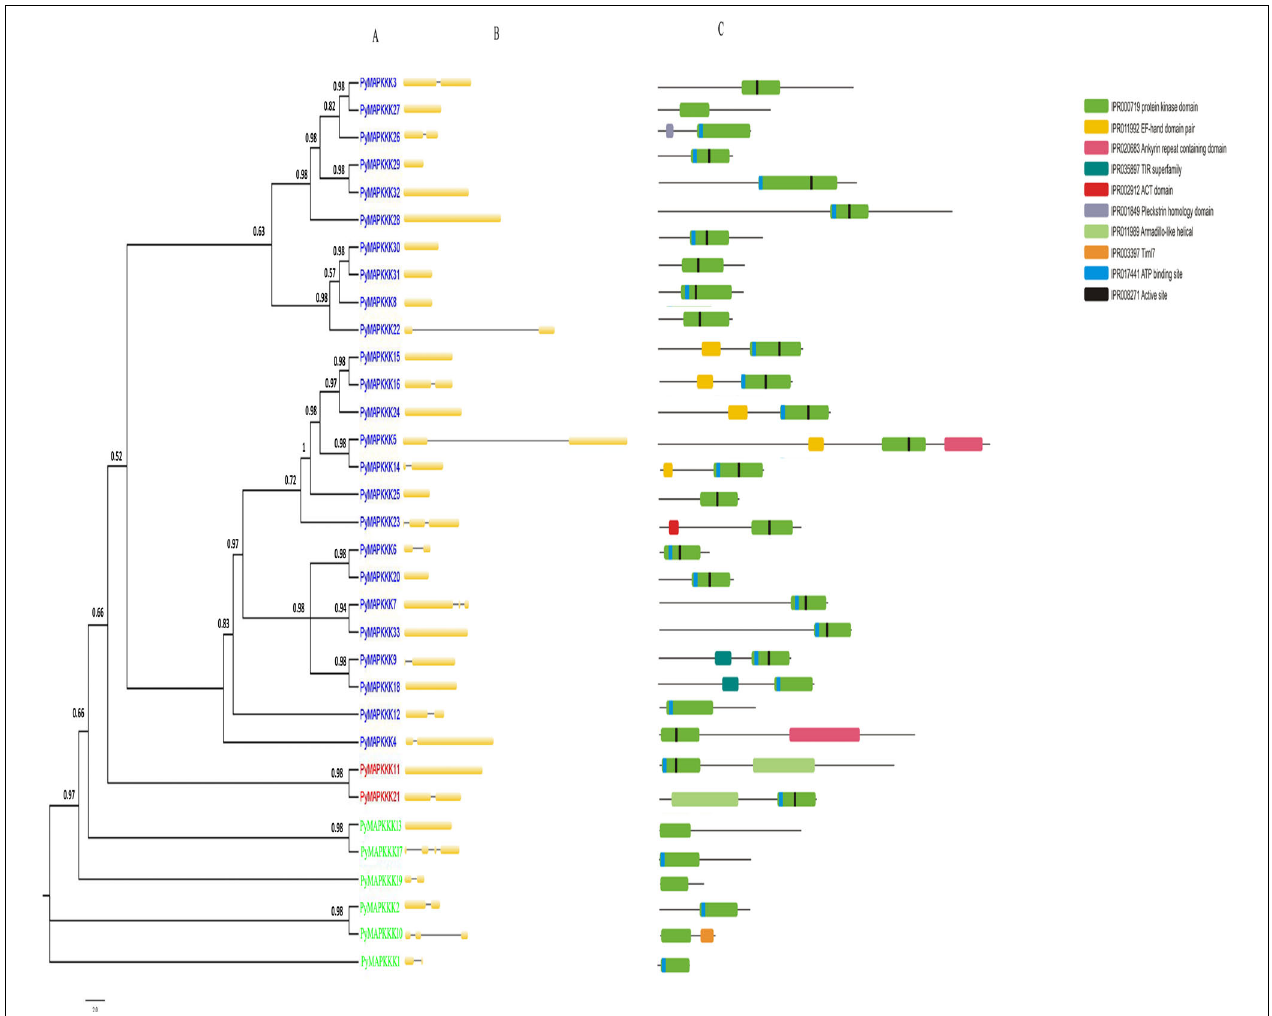
FIGURE 2 | Phylogenetic relationships, gene structures and protein structure of 33 PyMAPKKKs, (A) is the picture of PyMAPKKK evolutionary trees, (B) is the gene structure of PyMAPKKKs, (C) is the protein structure of